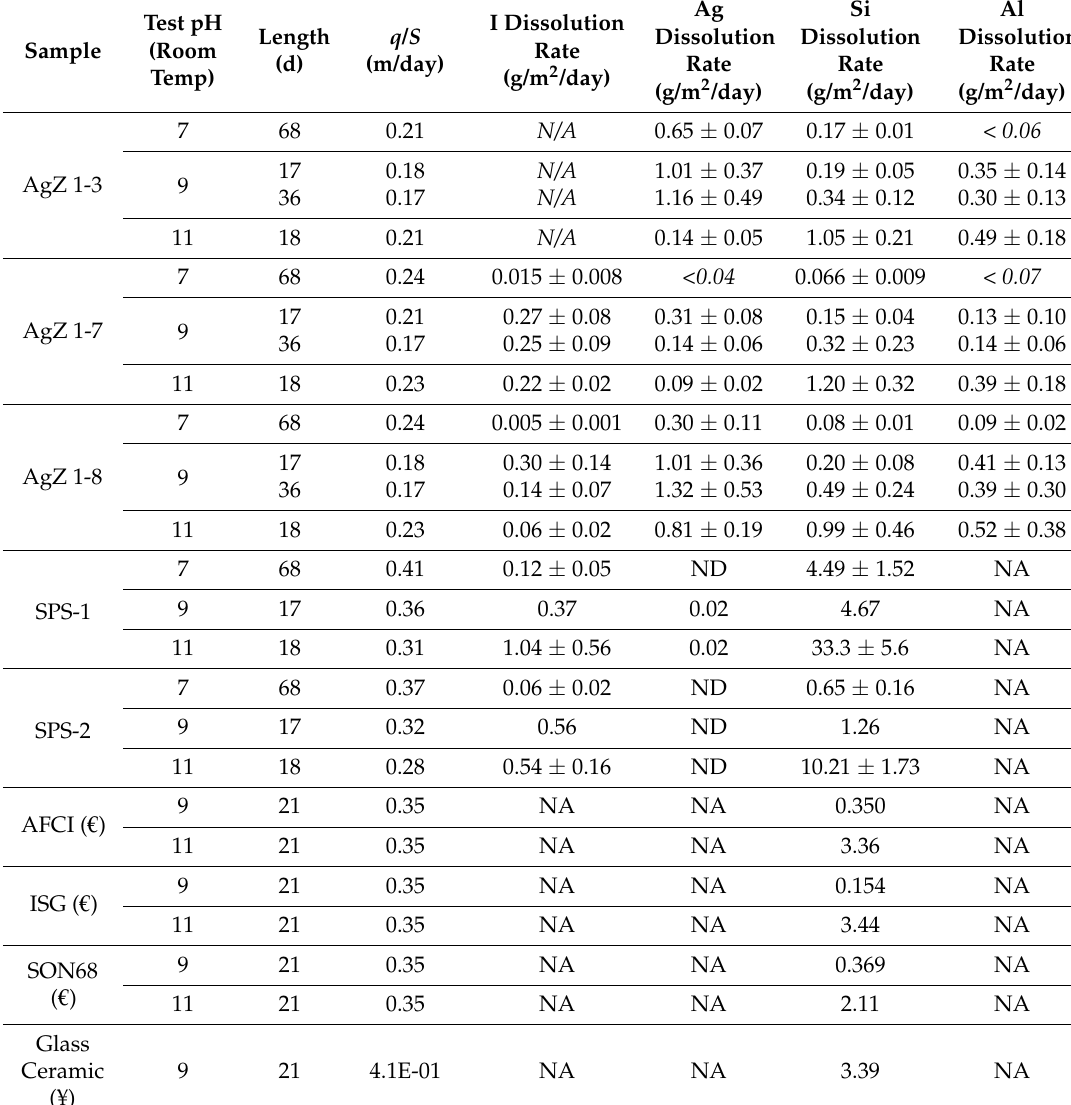
Table 5. Summary of the normalized dissolution rates measured with SPFT testing in this report and comparison to dissolution rates measured for other materials in similar test